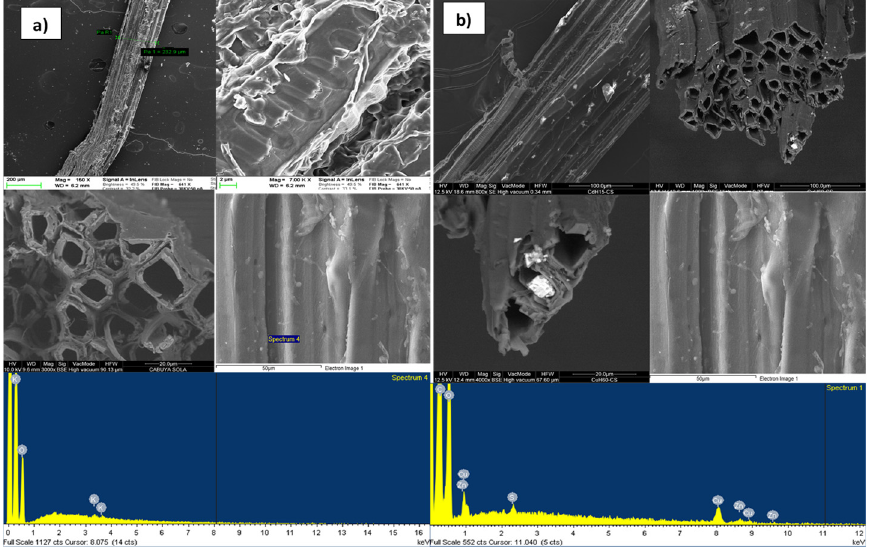
Figure 6. FESEM and EDX microphotographs of the cabuya fiber, ( a ) inlet of the column. ( b ) outlet of the column.